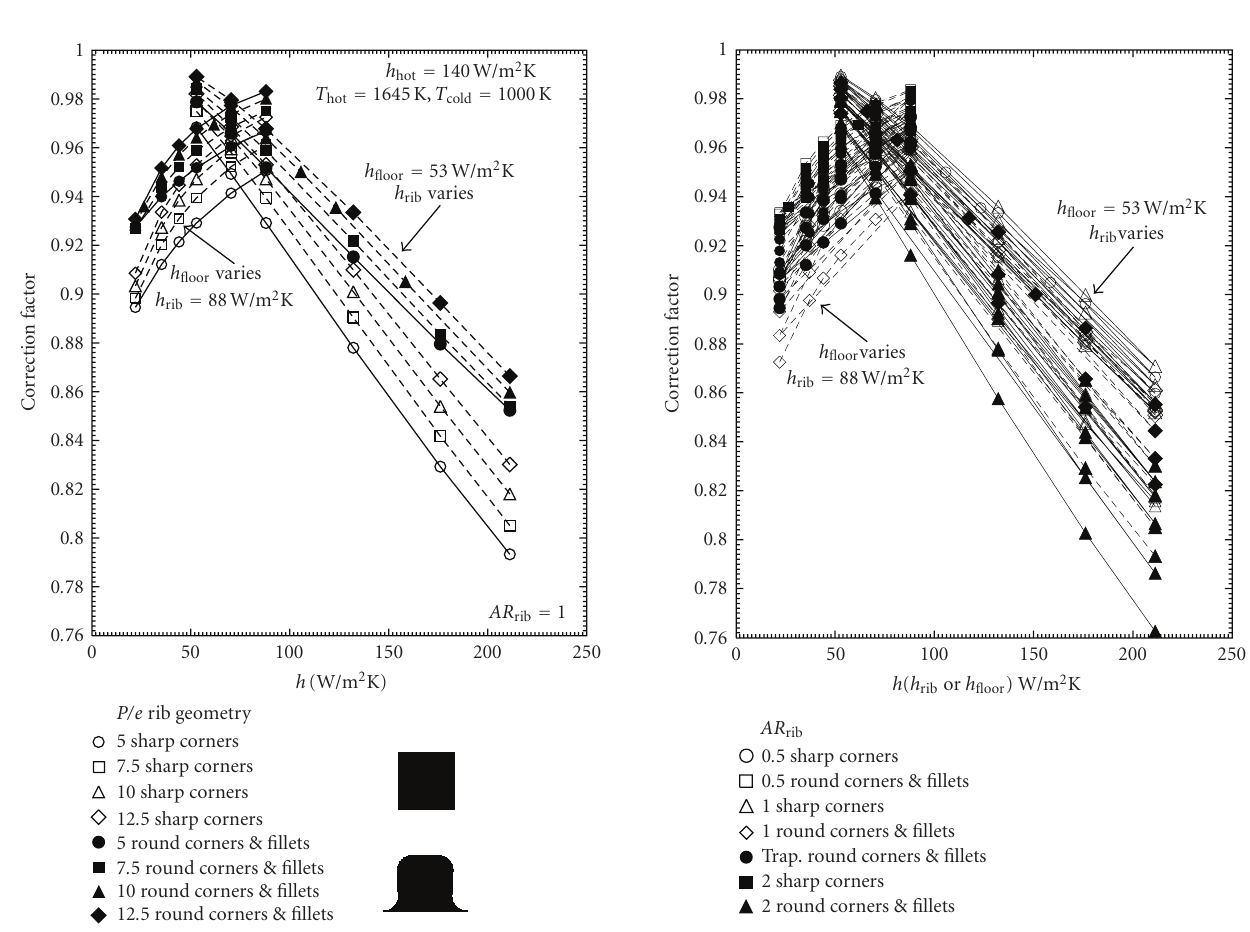
Figure 7: Correction factor variation with h rib and h floor for all rib